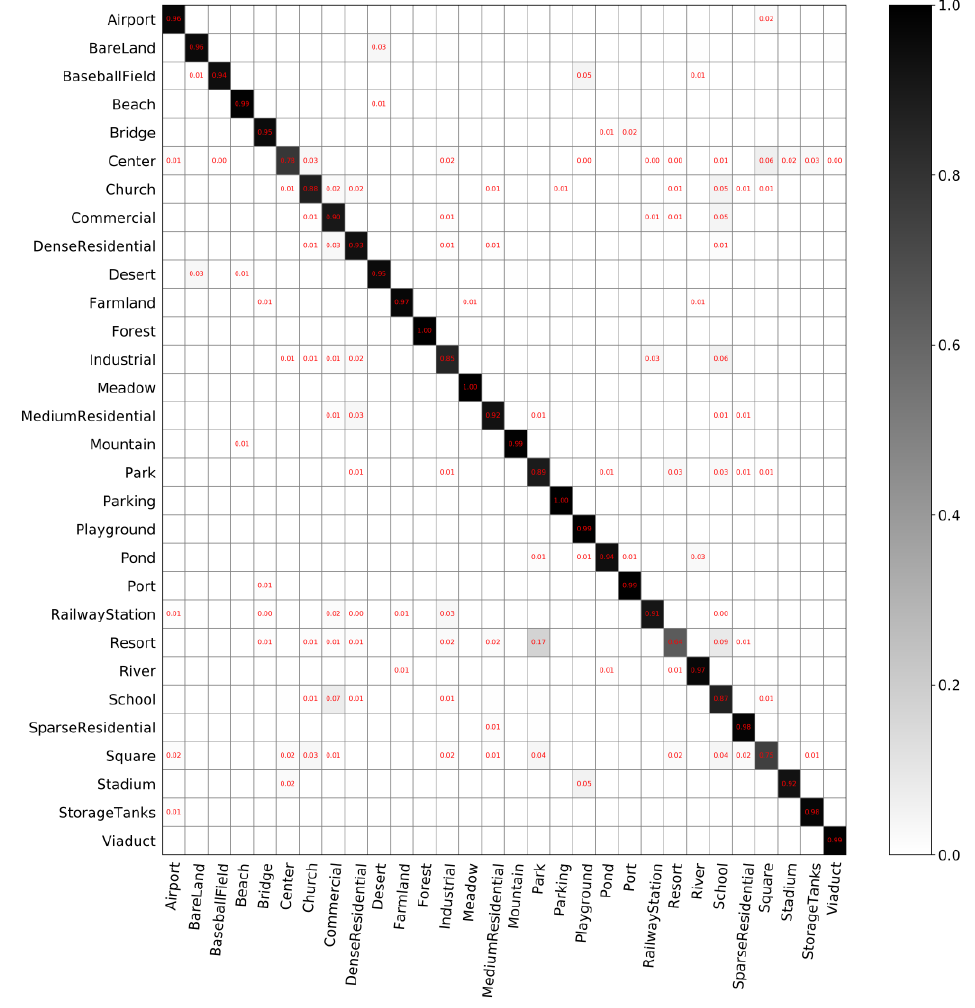
Figure 5. Confusion matrix on AID with training set of 10% and validation set of 10%.